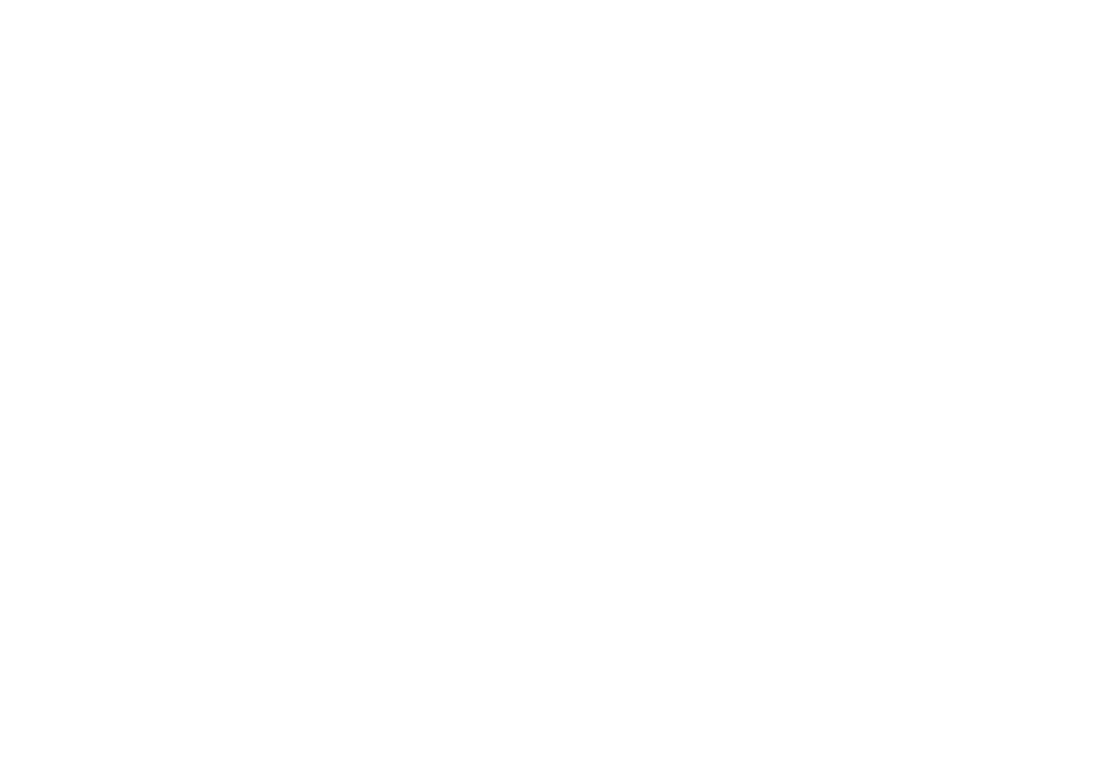
Figure 10. Comparisons of time histories calculated by NS in the sub-harmonic regimes: ( a ) time history at ̟ = 0.98 ; ( b ) time history at ̟ = 0.995 ; ( c ) time history at ̟ = 1.0 ; ( d ) time history at ̟ = 1.02